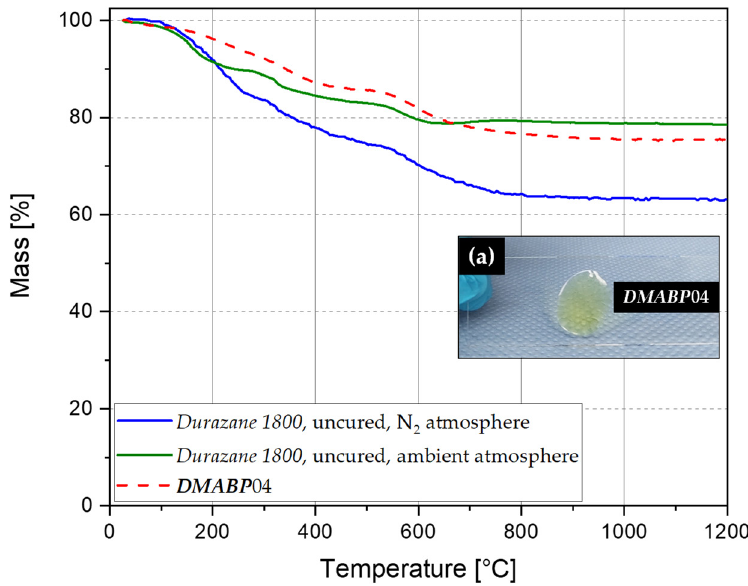
Figure 14. Thermograms of uncured Durazane 1800 measured in ambient and nitrogen atmosphere (olive and blue curve). The thermogram of DMABP 04 was measured in nitrogen atmosphere after curing by an LED source ( λ = 385 nm, N 2 ). (a) Drop of DMABP 04 on a slide after UV curing.